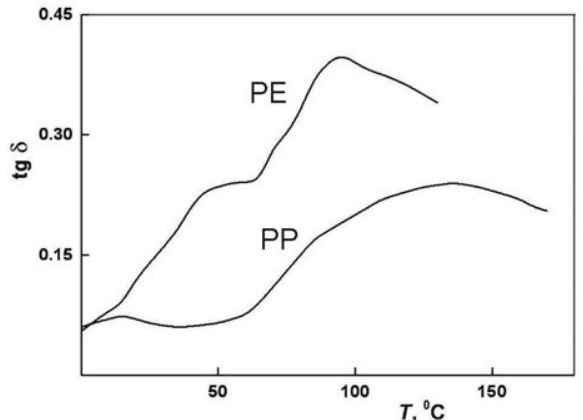
Figure 5. The temperature dependences of tg δ: PE and PP films. To establish a correlation between the density of the porous phase Ω (the surface area occupied by all types of p pores) and overall porosity P , the PP films obtained at dif- ferent T for which there is a linear relationship between ann these parameters were selected. In the case of the preva-